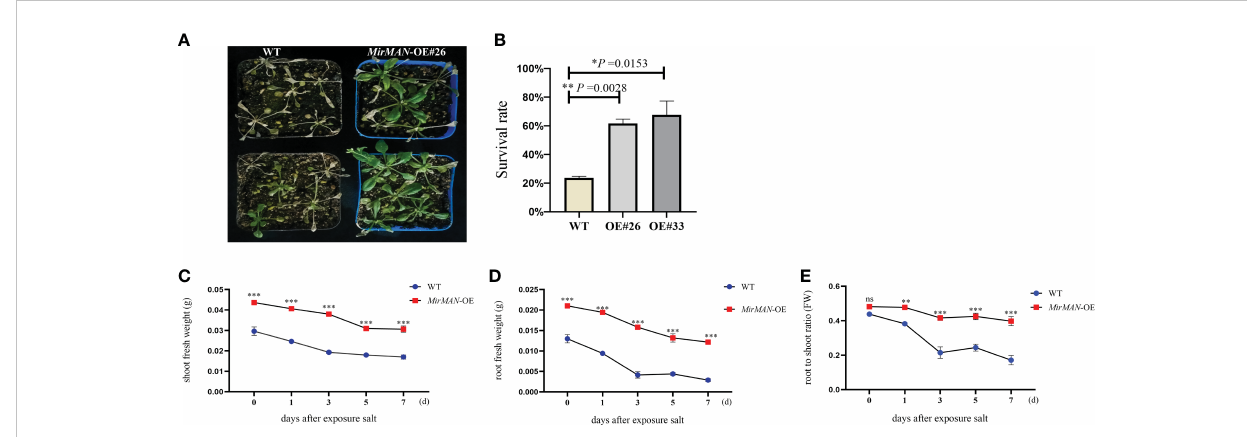
FIGURE 6 Effect of salt stress on MirMAN- overexpressed Arabidopsis plants. (A) Plants were grown on soil for 3 weeks and then exposed to 150 mM NaCl stress. (B) Survival rate under 150 mM NaCl stress. (C) Shoot fresh weight of plants. (D) Root fresh weight of plants. (E) Root-to-shoot ratio. n = 5. Error bars indicate ± SD. Student ’ s t -tests were used to compare the measurements of OE lines with those from wild type (WT). *p< 0.05, **p< 0.01, *** p< 0.001. ns represents no signi fi cance at p > 0.05.